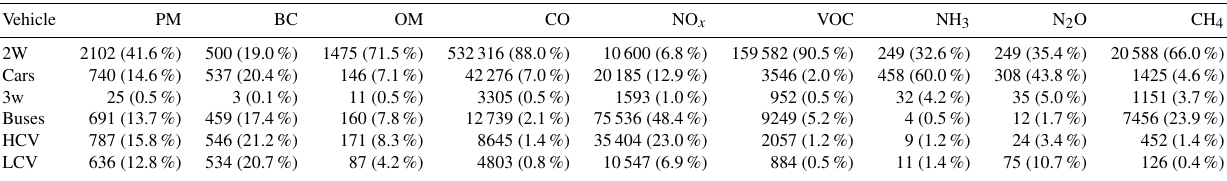
Table 2. Emission in kgd − 1 (% share) according to the vehicle types. Vehicle